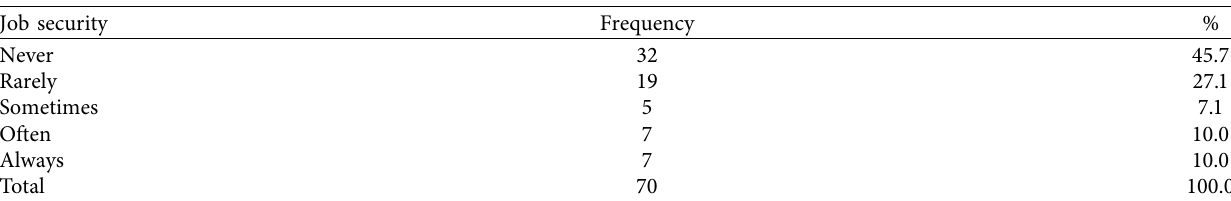
Table 25: Job security.